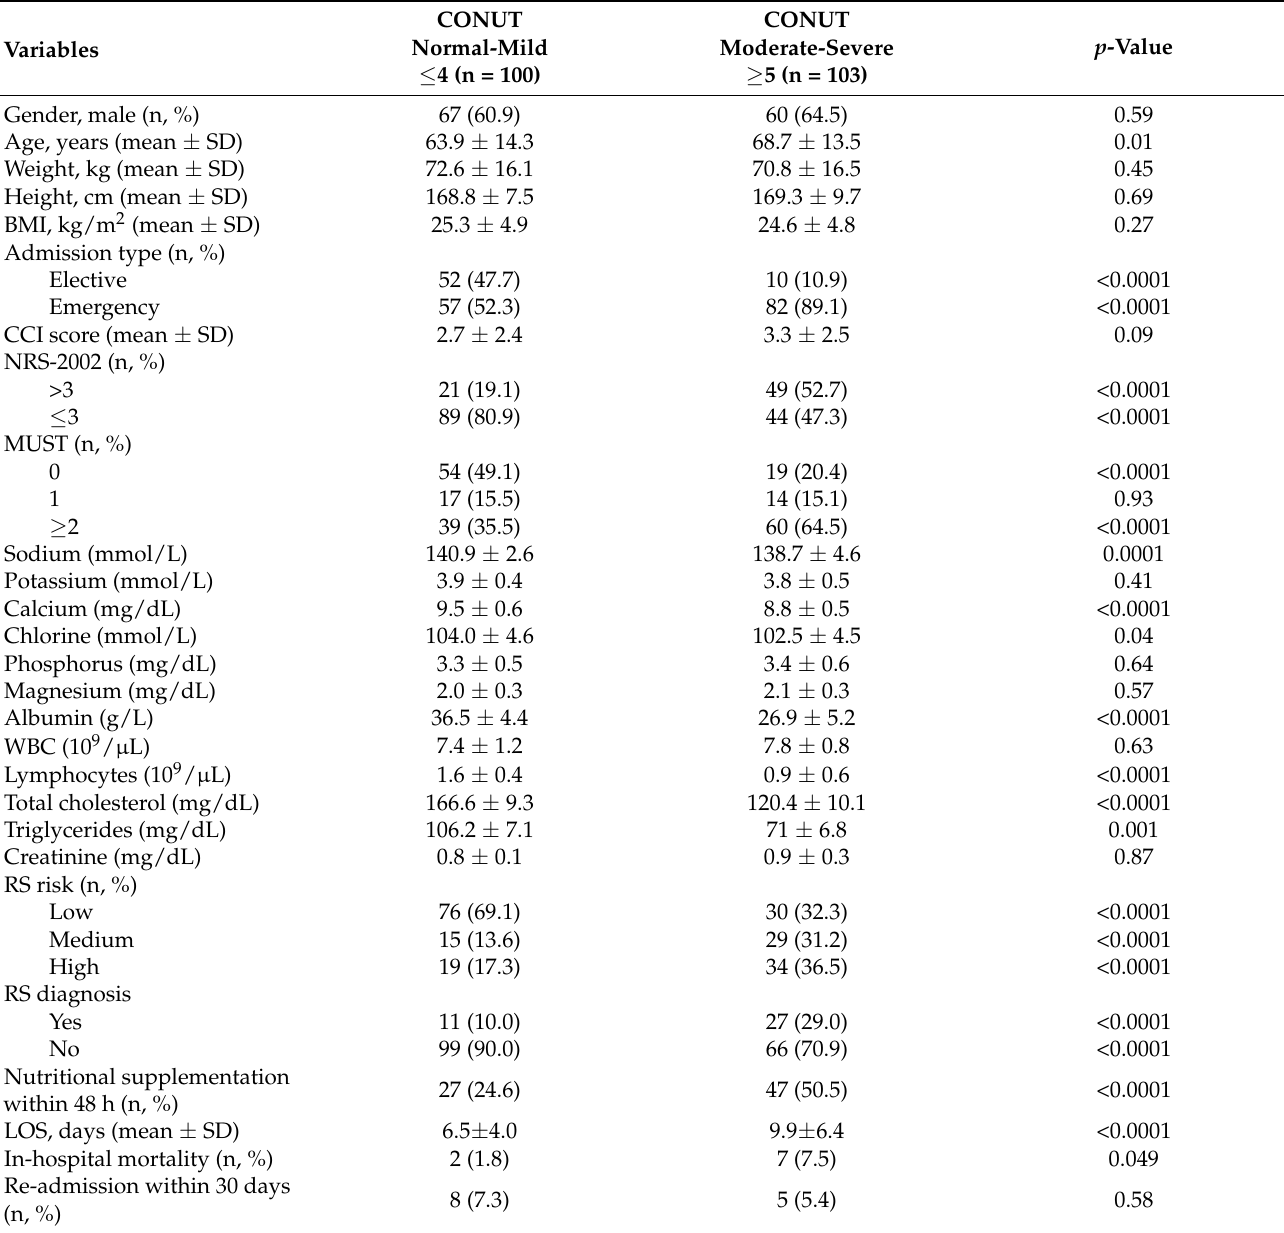
Table 3. Clinical and nutritional parameters according to CONUT